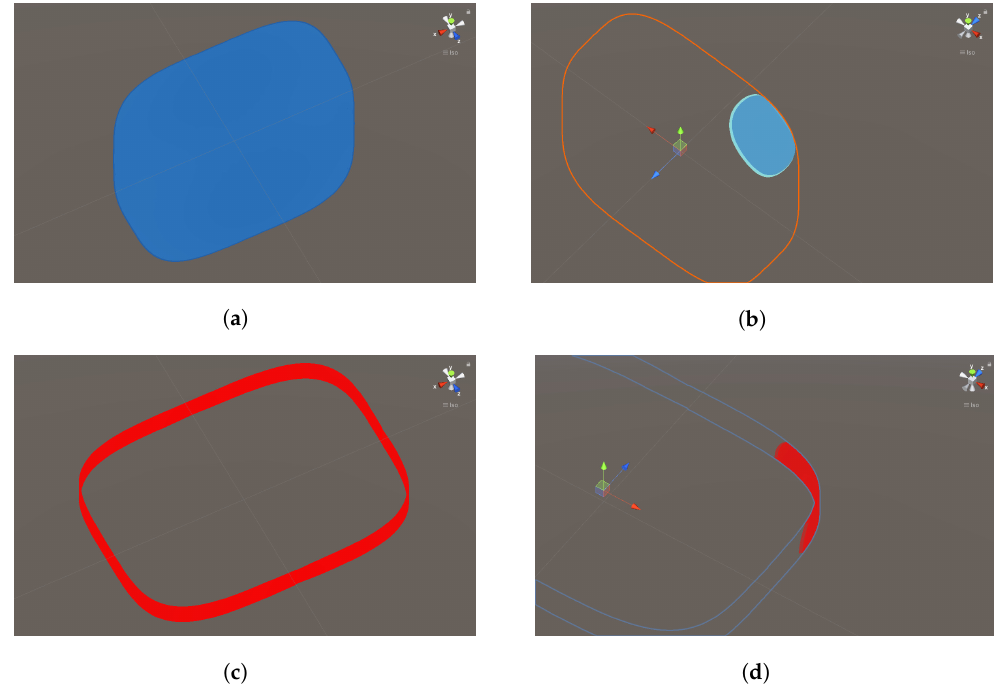
Figure 7. Proposed holograms for the robot 3D and 2D boundaries. ( a ) 3D boundary hologram (full).